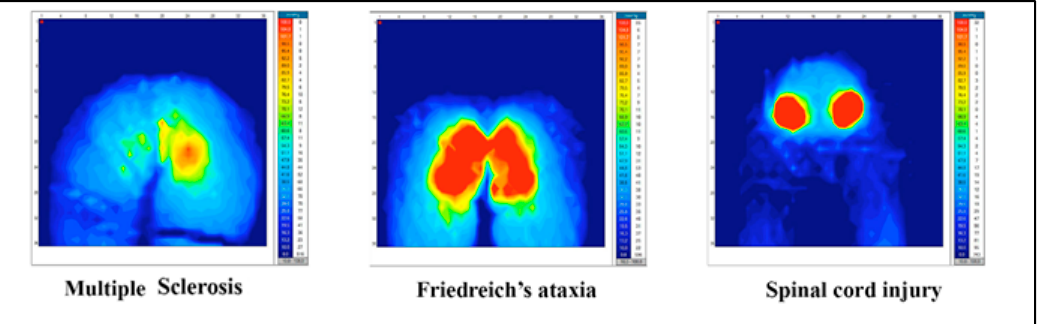
Figure 3. Examples of frames extracted from pressure mapping.